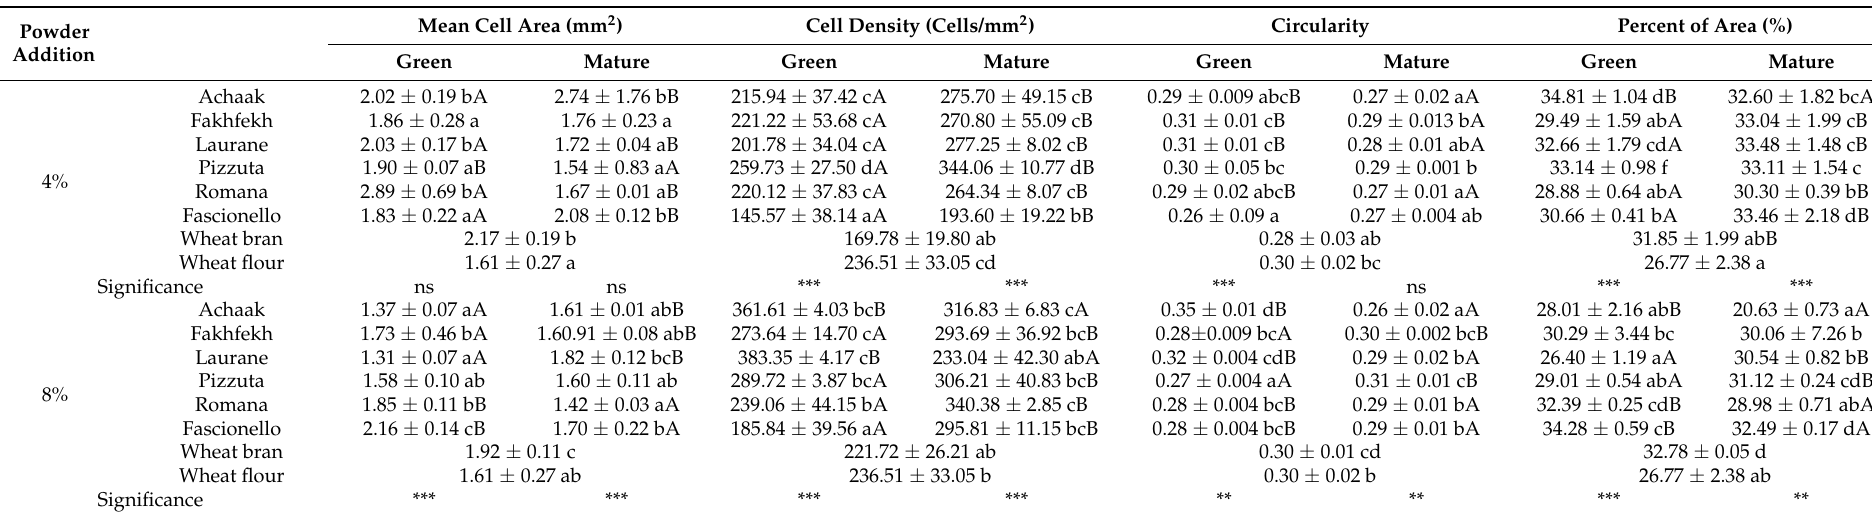
Table 7. Results of image-analysis parameters evaluated on the breads substituted with AH powders and results of variance analysis with Duncan’s test ( p < 0.05) performed between the products and the two harvesting times (green and